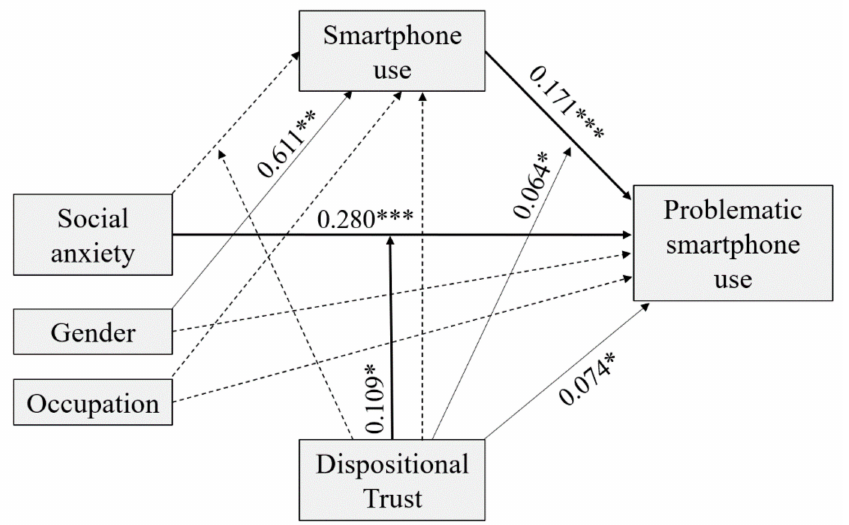
Figure 2. Results for the final moderated mediation model. Note: gender (1 = male, 2 = female) and current occupation (1 = non-students, 2 = students), * p < 0.05; ** p < 0.01; *** p < 0.001. Only significant path coefficients are displayed. Dotted lines display non-significant